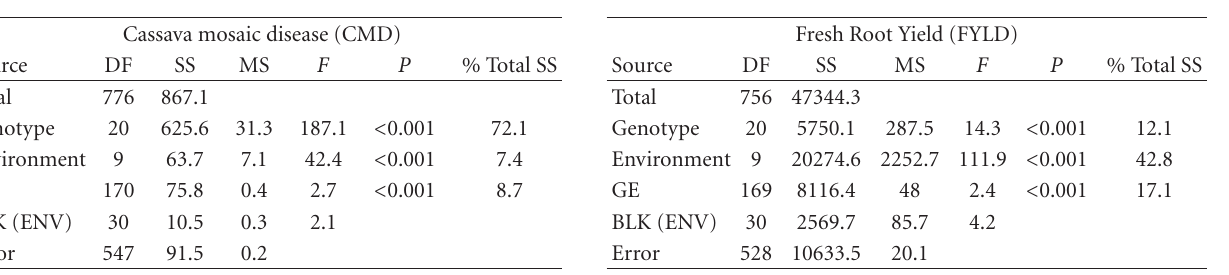
1 : genotypes used as checks. Means with the same letter in a column are not significantly di ff erent at 95% level.